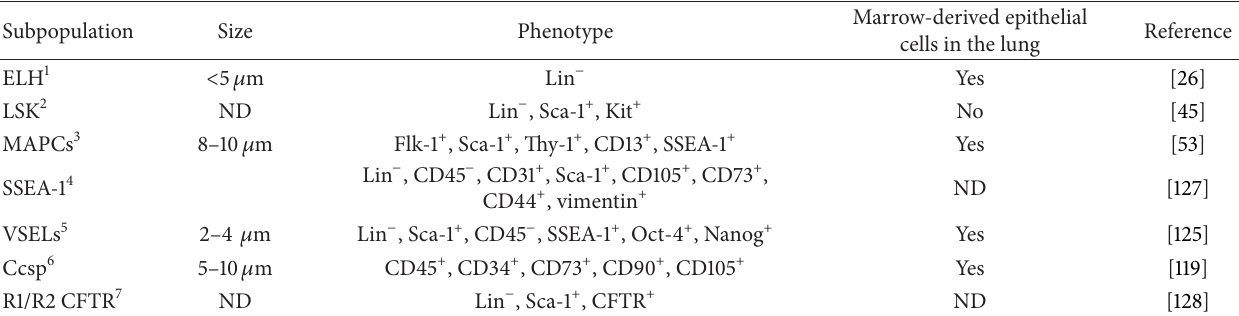
Table 1: Characteristics of marrow-derived stem cell subpopulations in murine